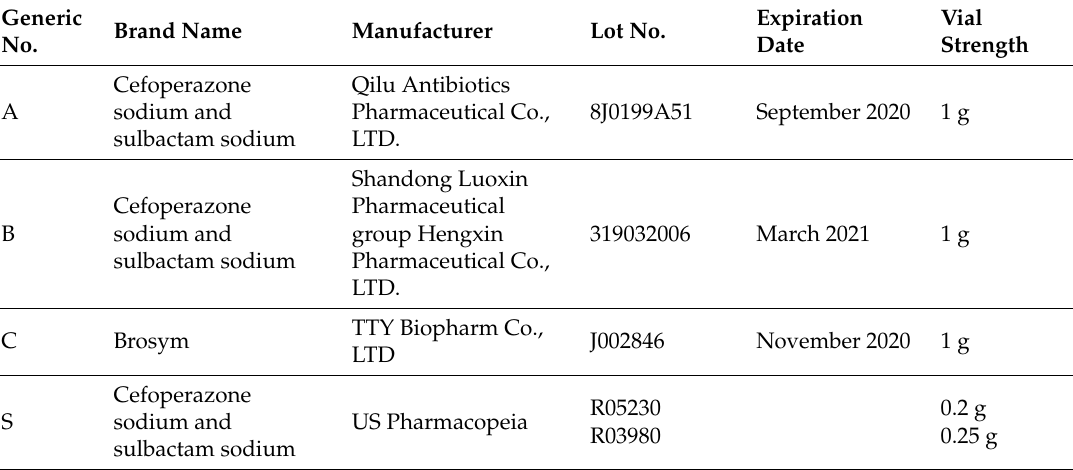
Table 1. List of three cefoperazone / sulbactam